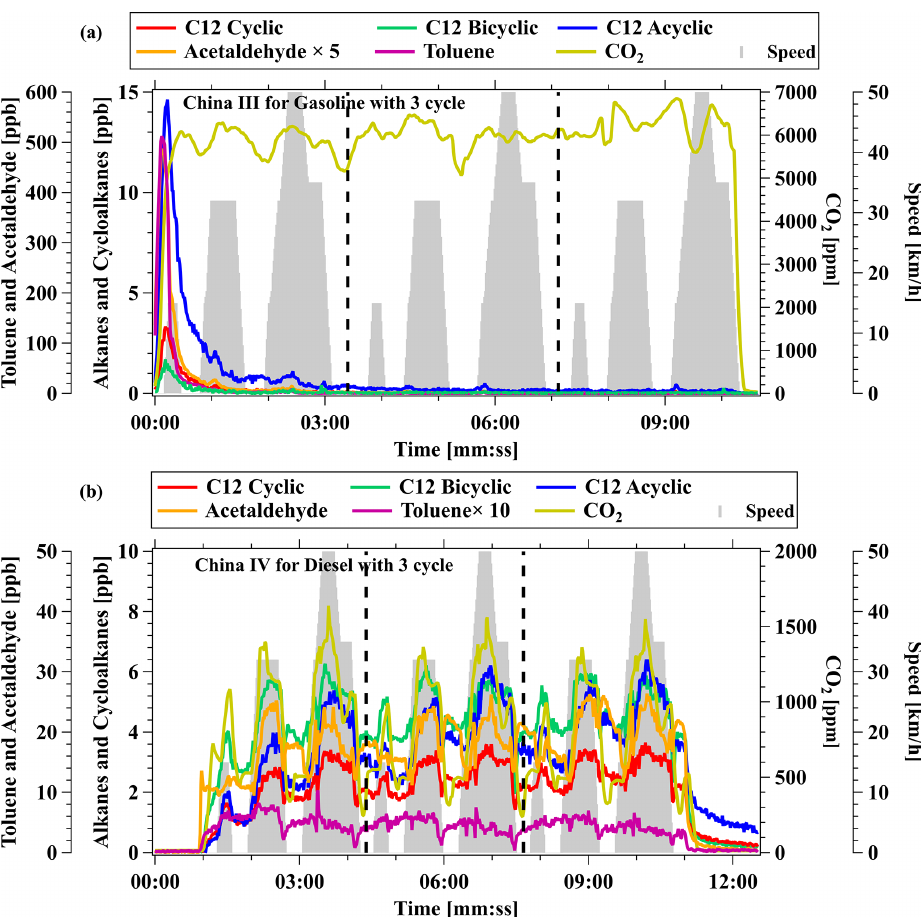
Figure 7. Concentrations of C 12 cyclic, bicyclic, and acyclic alkanes; acetaldehyde; toluene; and CO 2 for (a) a gasoline vehicle with emission standard of China III and (b) a diesel vehicle with emission standard of China IV. The gray shadows represent the speeds of the vehicles on the chassis dynamometer. The data of toluene and acetaldehyde were detected by NO +